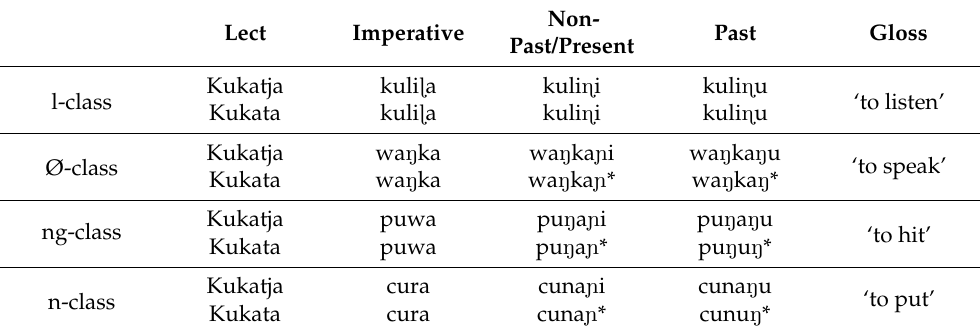
Table 7. Tense suffixes in Kukatja vs. Kukata, adapted from Platt (1968). Lect Imperative